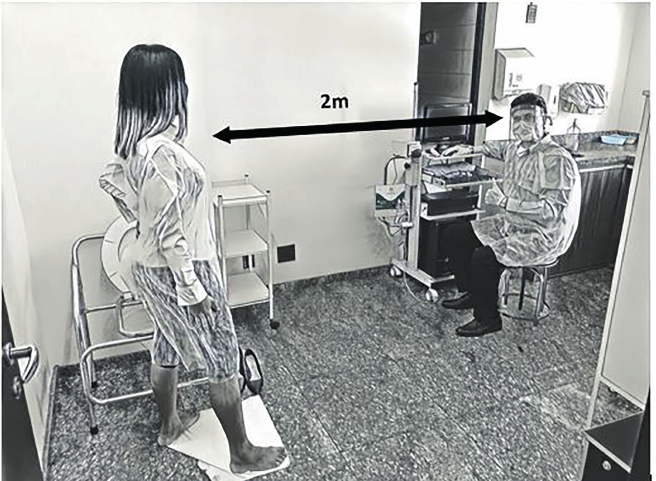
Figure 1 - Adaptations for urodynamic performance include: single-use gloves, apron, mask; and eye protection for staff; mask for the patient and maintenance of 2 meters distance between examiner and patient; the patient is standing for stress incontinence maneuvers (straining) with a pad placed on the floor to facilitate observation of urine leakage from